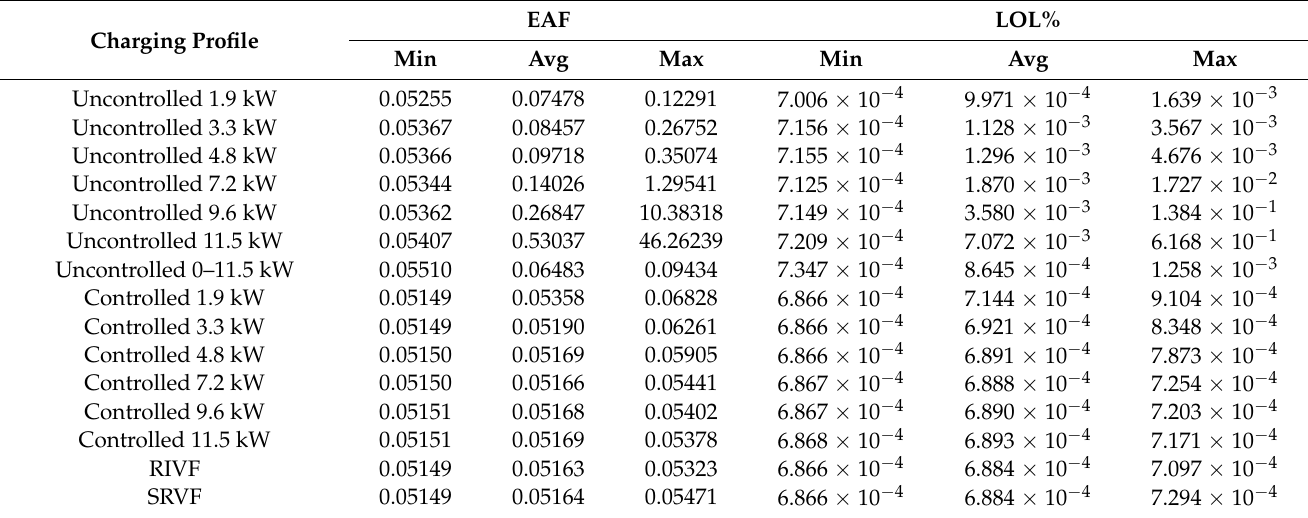
Table 10. Equivalent aging factor and transformer loss of life for a period of 24